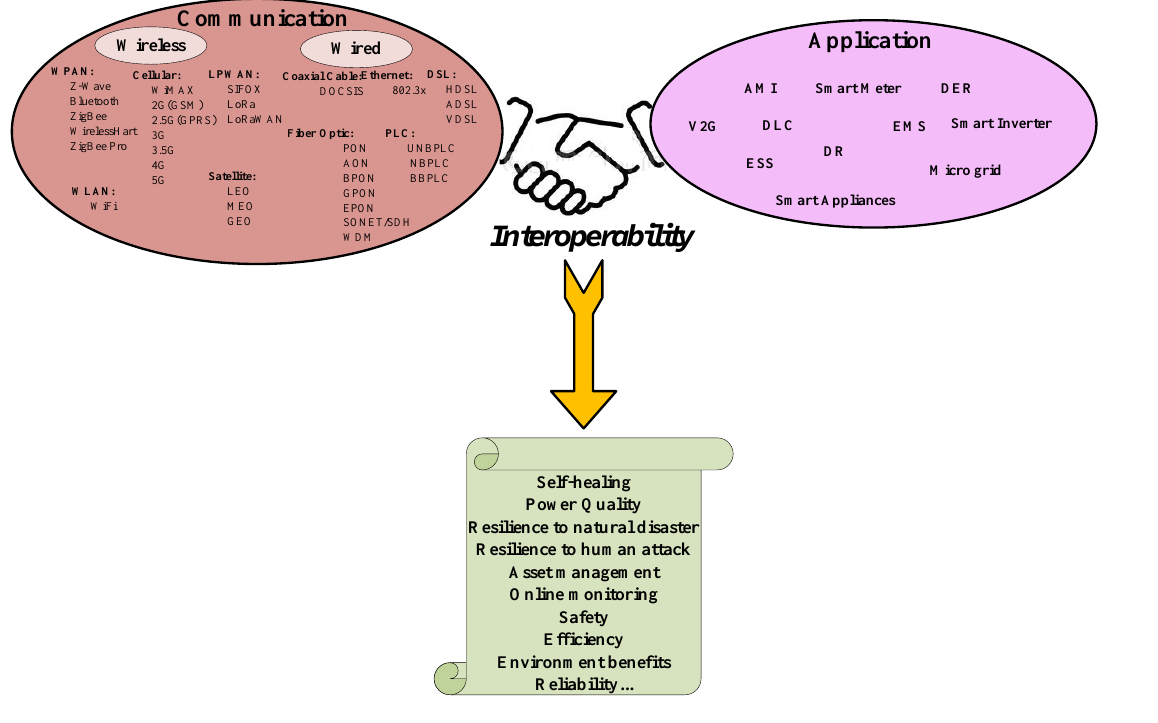
Figure 1. Achievement of the smart grid advantages by equilibrium among applications, communication, and